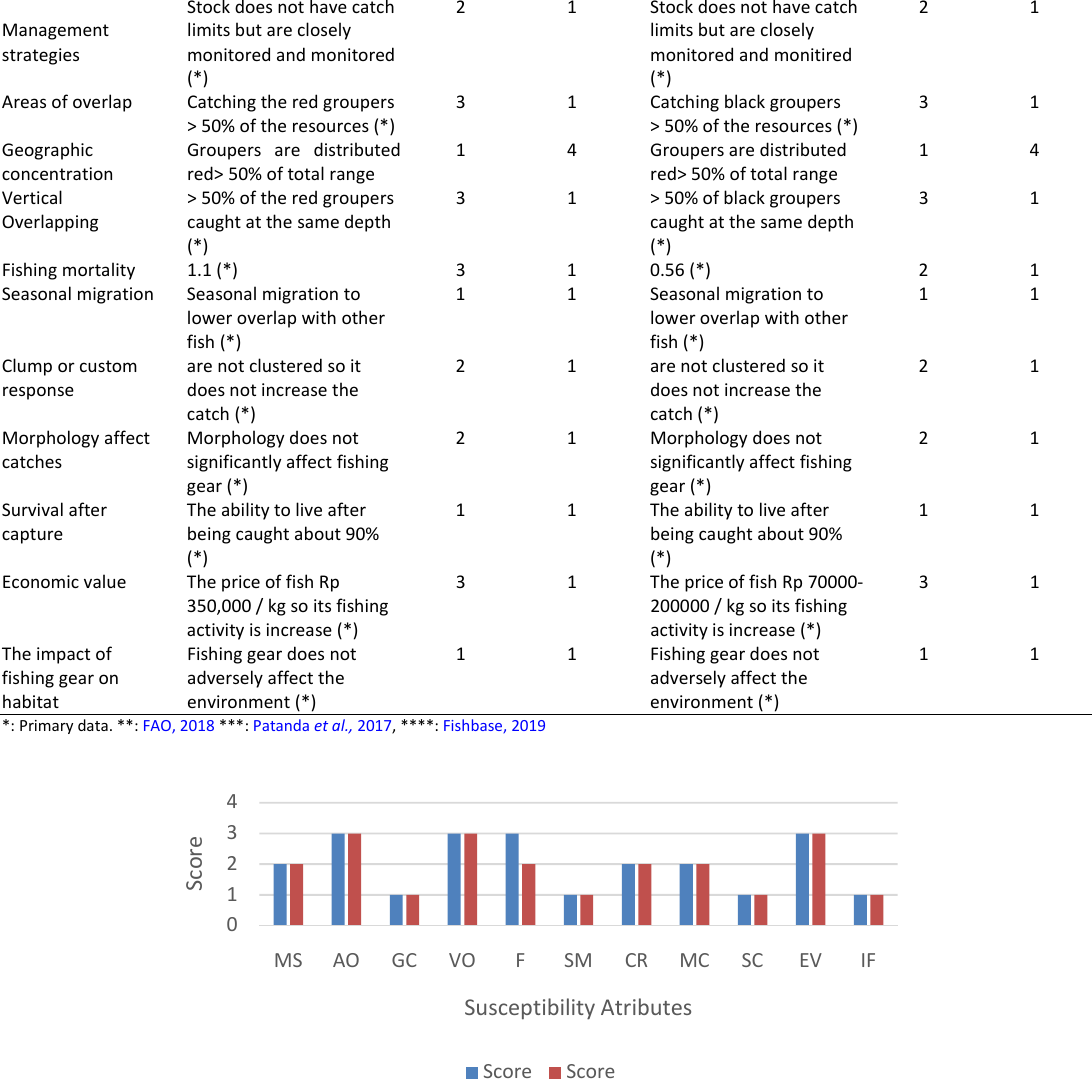
Fig. 4: Score of Plectropomus areolatus and Plectropomus leopardus based on Susceptibility Attributes. MS, Management strategies; AO, Areas of overlap; GC, Geographic concentration; VO, Vertical Overlapping; F, Fishing mortality; SM, Seasonal migration; CR, Clump or custom response; MC, Morphology affect catches; SC, Survival